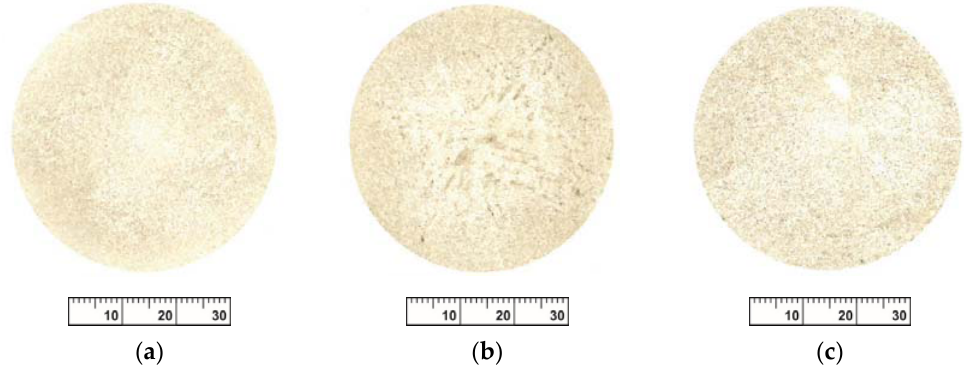
Figure 7. Results of Baumann print of the CMnCr steel: ( a ) without Bi, ( b ) with 0.08 wt. % Bi, ( c ) with 0.12 wt. % Bi.